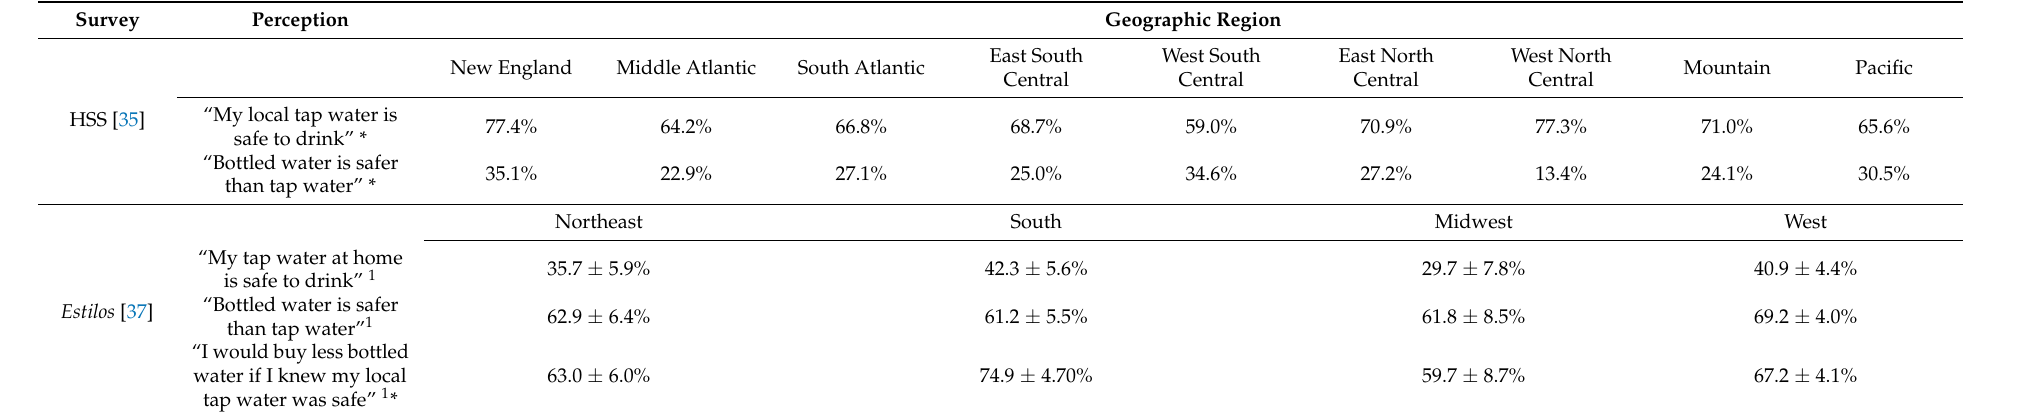
Table 5. Prevalence of agreement with perceptions by geographic region among survey